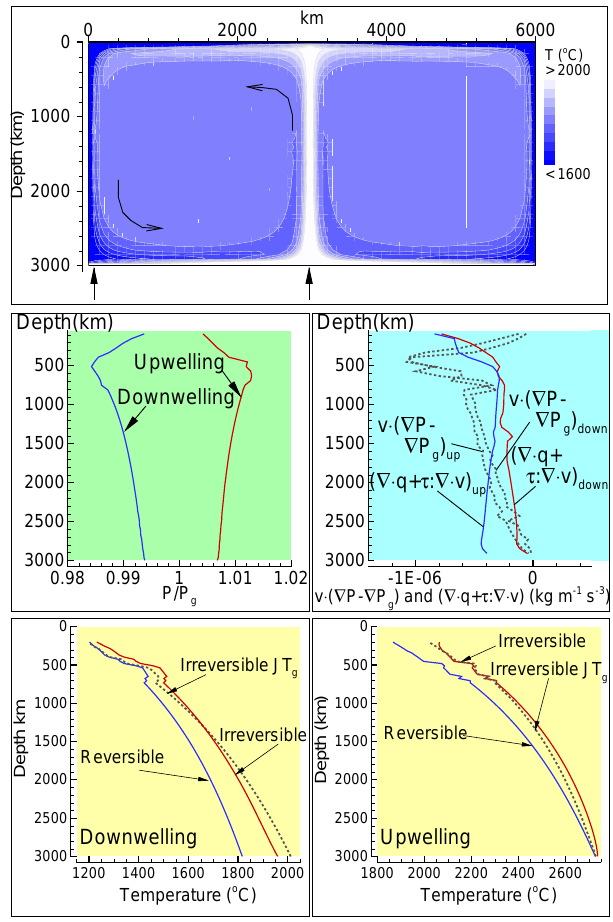
Figure 2. The upper panel shows temperature for an isoviscous mantle convection simulation (heated from below) coupled with a thermodynamic model. Temperature at the bottom is set to 3327 ◦ C. In the geodynamic model the thermal field does not in- clude the reversible adiabatic and viscous dissipation effects. The middle left panel shows the ratio between the flow pressure and the gravitational pressure P g = ρg d z . The middle right panel shows the irreversible contribution to the thermal gradient given by heat conduction and viscous dissipation (solid lines) and the irreversible contribution in the JT formulation including the gravitational ef- fect (dashed lines; see Eq. 13). The lower panel shows the thermal gradient computed from the isentropic formulation (reversible), the irreversible formulation by adding heat conduction and viscous dis- sipation (irreversible) and the JT formulation with gravity (dashed lines, irreversible JT g